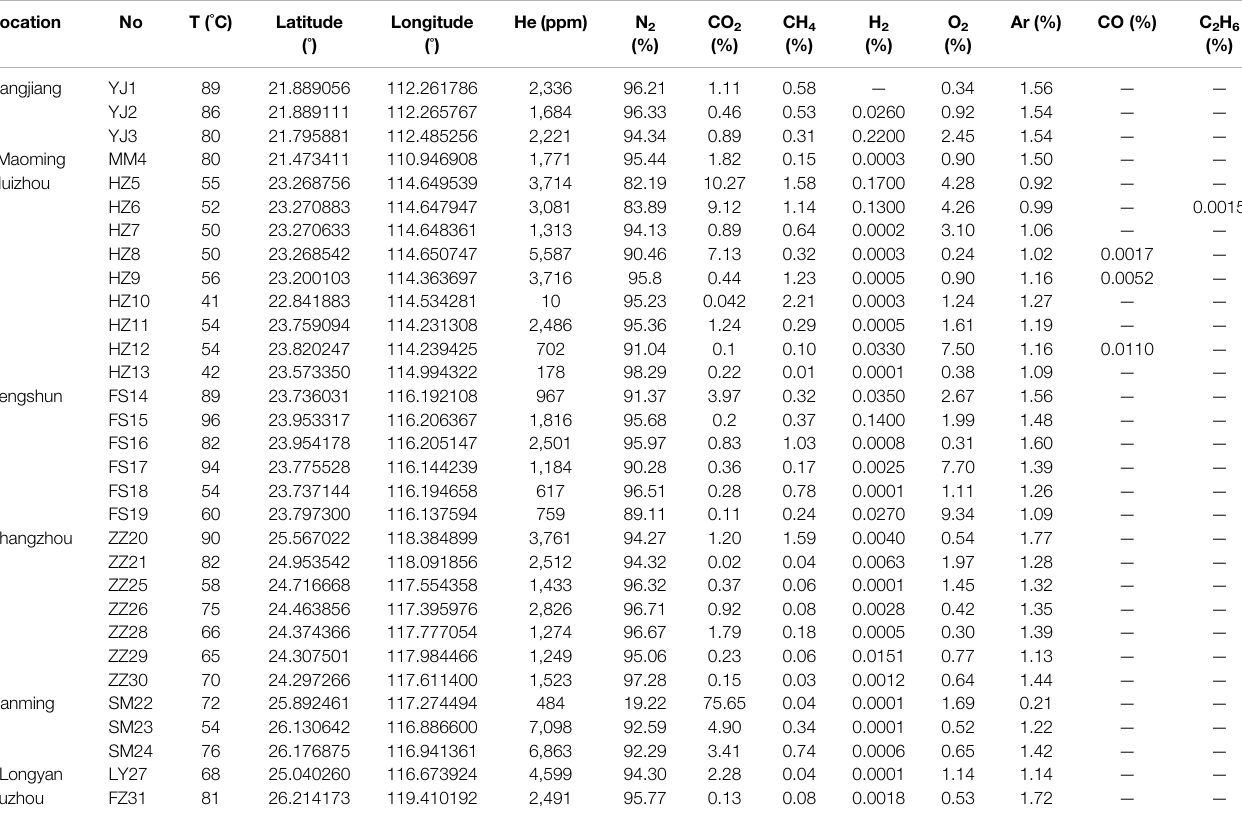
TABLE 1 | Chemical composition of hydrothermal volatiles from Southeast China in this study ( “ - ” represents the content lower than the detection limit 0.0001%). Location No